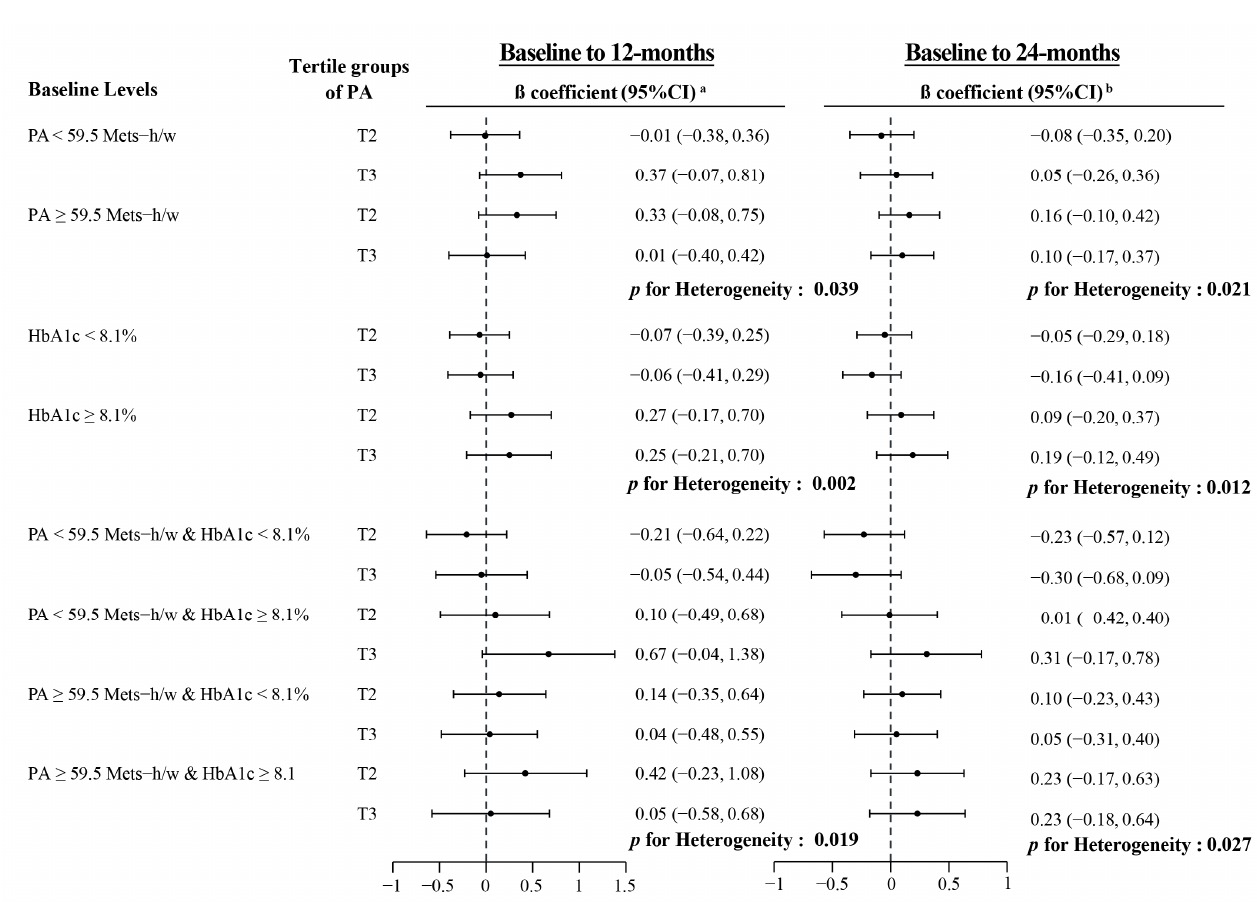
Figure 3. β coefficients and 95% confidence intervals for PA with HbA1c at 12 and 24 months by initial levels of PA and HbA1c. a Two-level mixed regression models with individuals as the level-2 observations and intervention status as shown in Table 1 and adjusted for age, sex, use of anti-diabetes agents and insulin, duration of diabetes, and initial PA level (for stratified analysis by initial HbA1c only) or initial HbA1c level (for stratified analysis by initial PA only); b Three-level mixed regression models with individuals as the level-3, intervention status as the level-2 and repeated measurements of PA as the level-1 observations, and adjusted for age, sex, use of anti-diabetes agents and insulin, duration of diabetes, and initial PA level (for stratified analysis by initial HbA1c only) or initial HbA1c level (for stratified analysis by initial PA only).